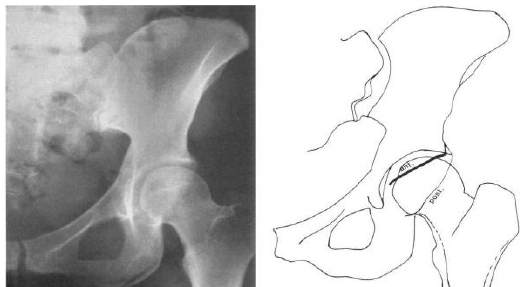
Figure 2 :Radiographs and outline diagram of the normal (anteverted) acetabulum .(5)